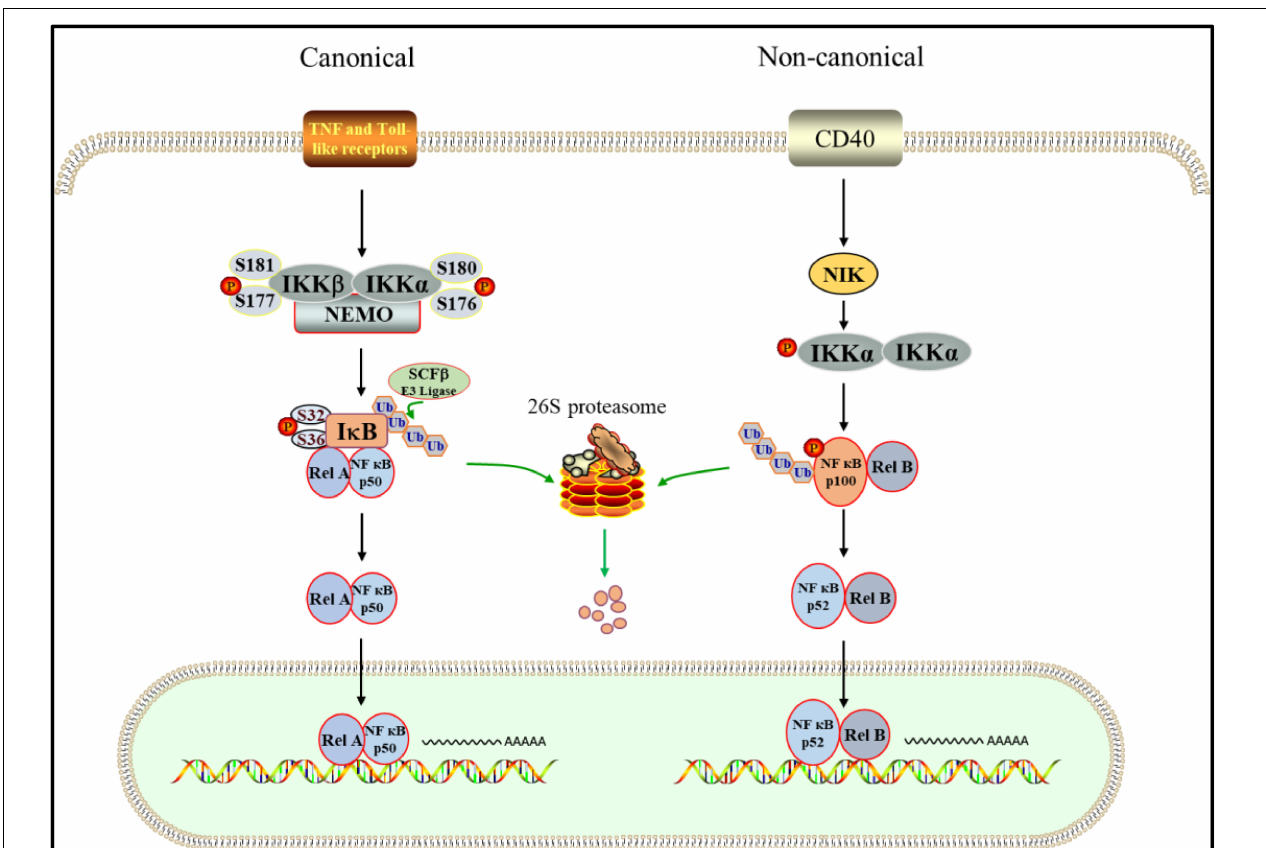
FIGURE 2 | UPS is involved in canonical and non-canonical NF- κ B pathway. In the canonical way. After the inflammatory receptor is activated, the activated IKK complex phosphorylates ser32 and ser36 of I κ B, which promotes the ubiquitination of I κ B mediated by SCF β . Subsequently, I κ B is targeted to the 26S proteasome for proteolysis. NF- κ B dimer was released and transferred into the nucleus to start the transcription of target genes. In the non-canonical pattern. IKK is activated by NIK, which leads to phosphorylation of p100. Then, Phosphorylated p100 is degraded by proteasome after ubiquitination, in which p52-RelB heterodimer is produced. Finally, the p52-RelB heterodimer enters the nucleus to start